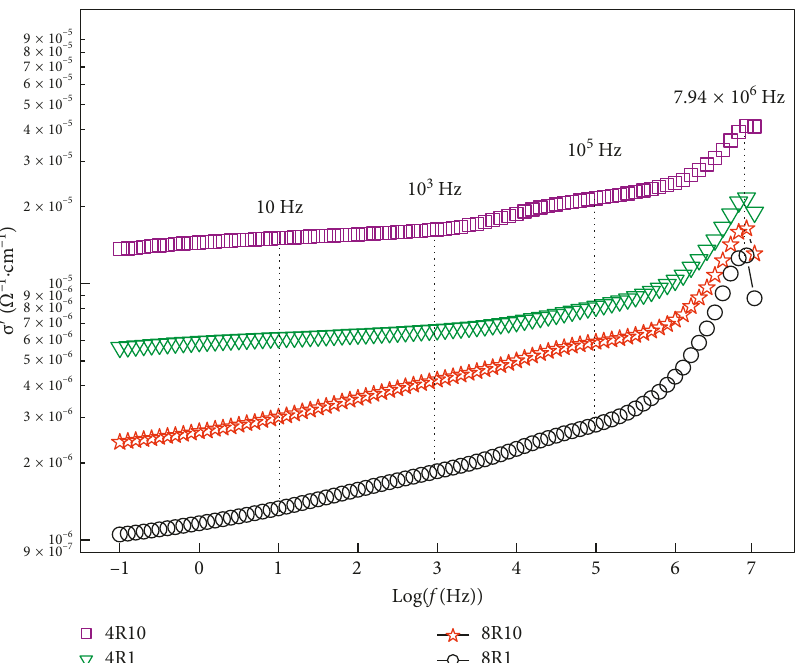
Figure 4: Effect of the synthesis temperature and the heating rate on the conductivity of the